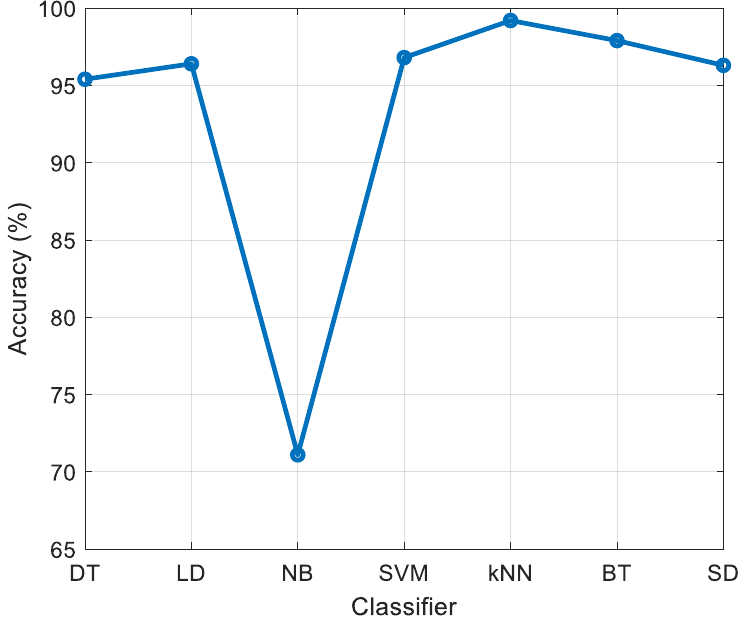
Figure 8. Classification accuracy (%) obtained for various classifiers using 1024 generated features. The performance parameters (%) obtained for automated COVID-19 detection using cough sound signals is depicted in Table 2. Table 2. Performance metrics (%) obtained for automated COVID-19 detection using cough sound